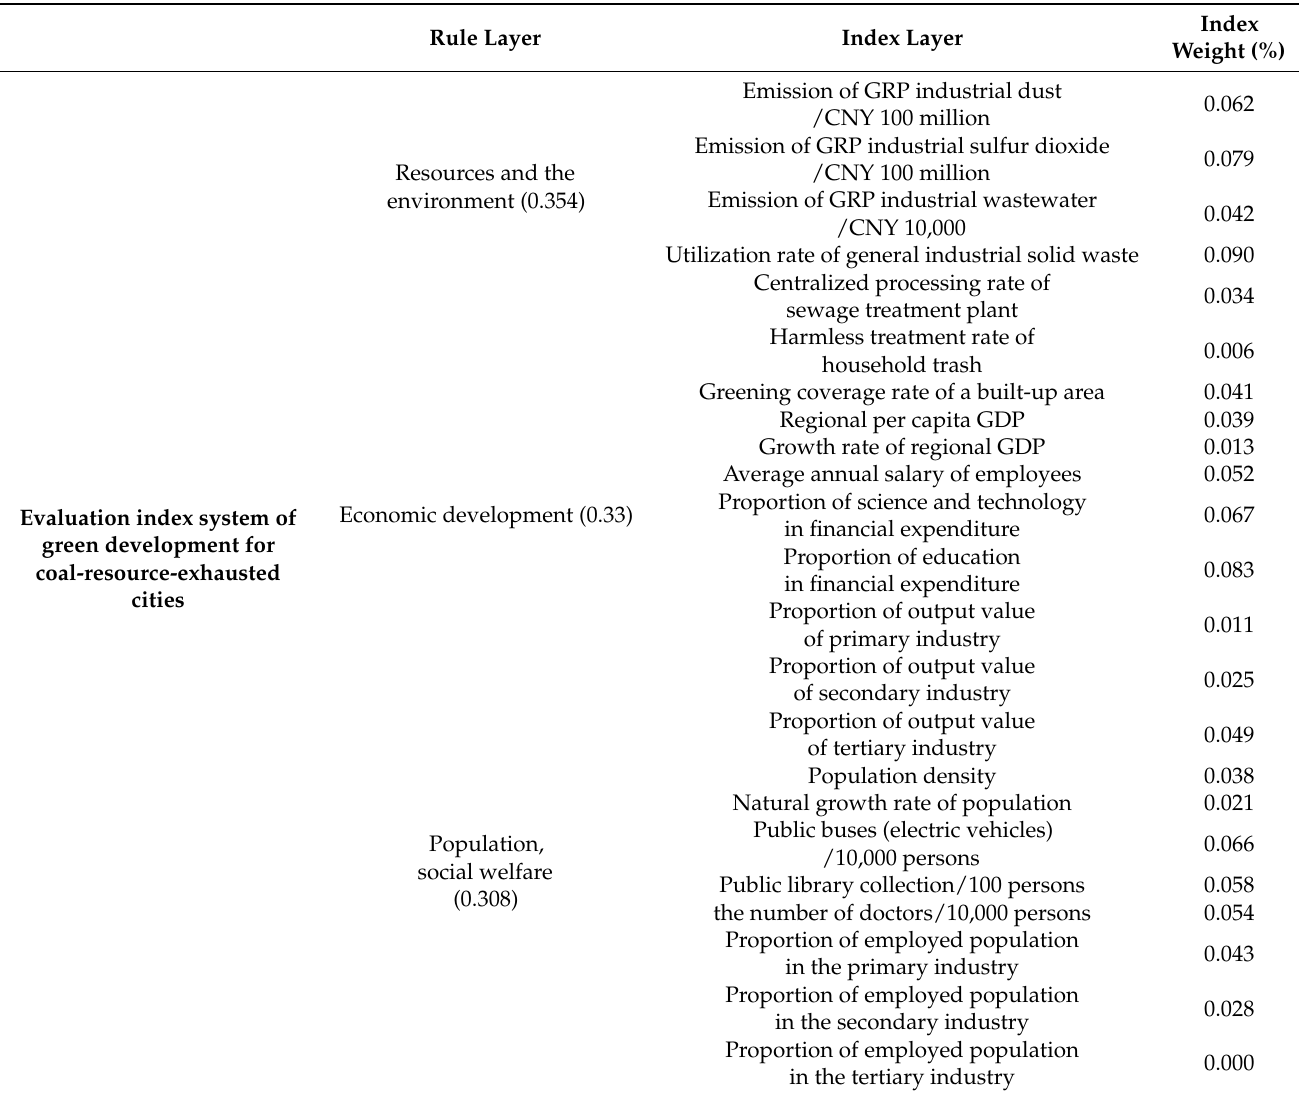
Evaluation index system of green development of coal-resource-exhausted cities after